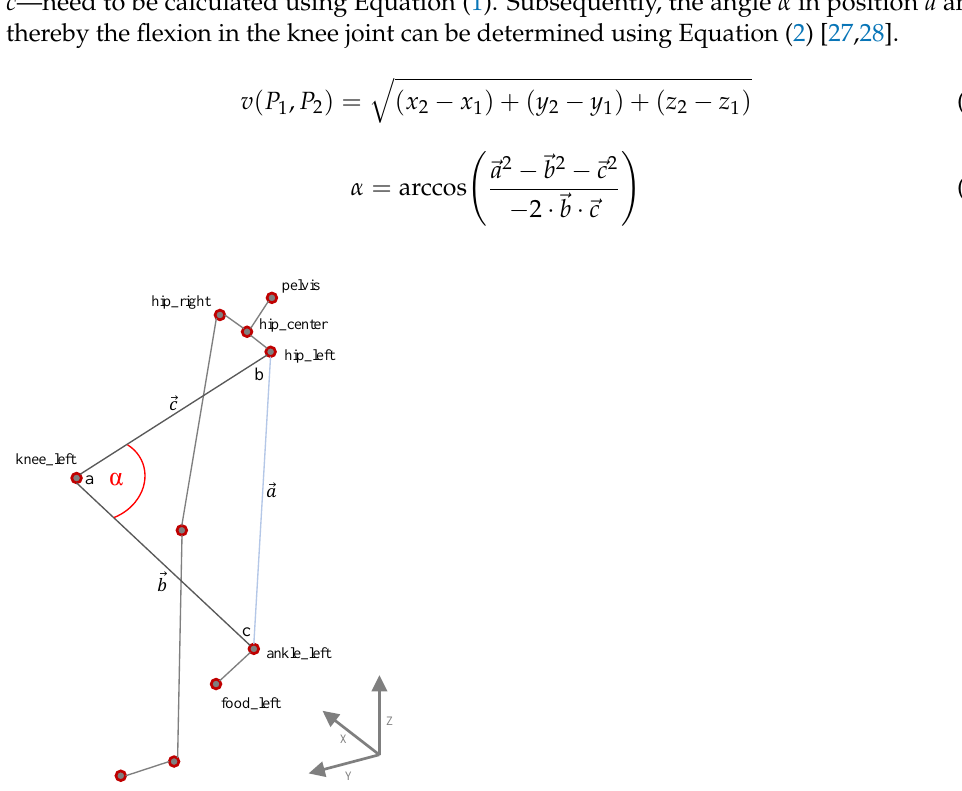
Figure 5. Calculation of flexion angles based on three Cartesian joint positions (x, y, z) using the example of left knee